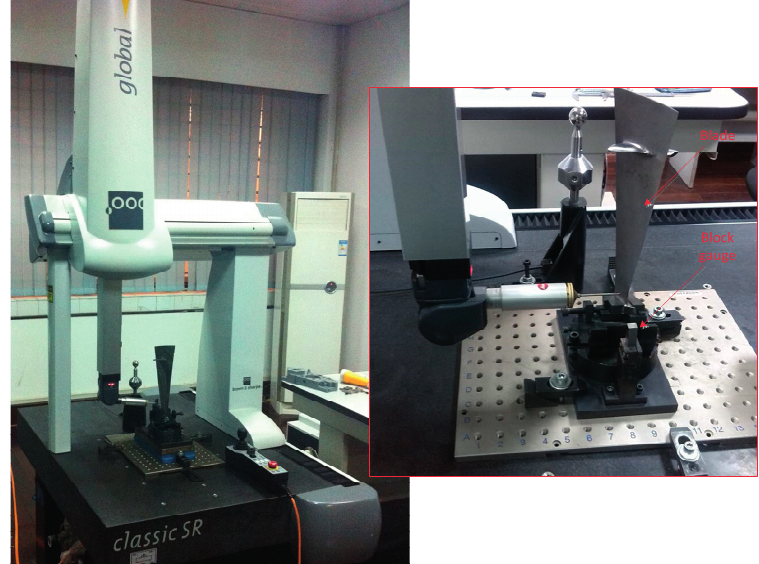
Figure 15. The CMM measuring the blade section